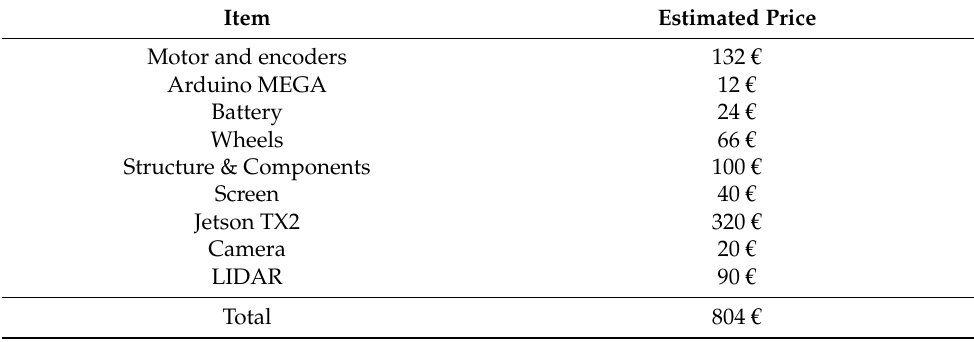
Table 1. A list with the prices of the main components needed to build our platform.